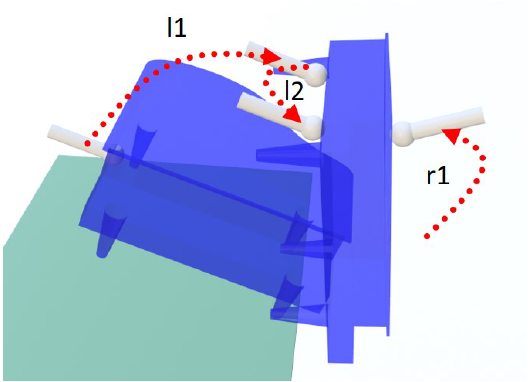
Figure 14. Tumbling motion by incorporating two